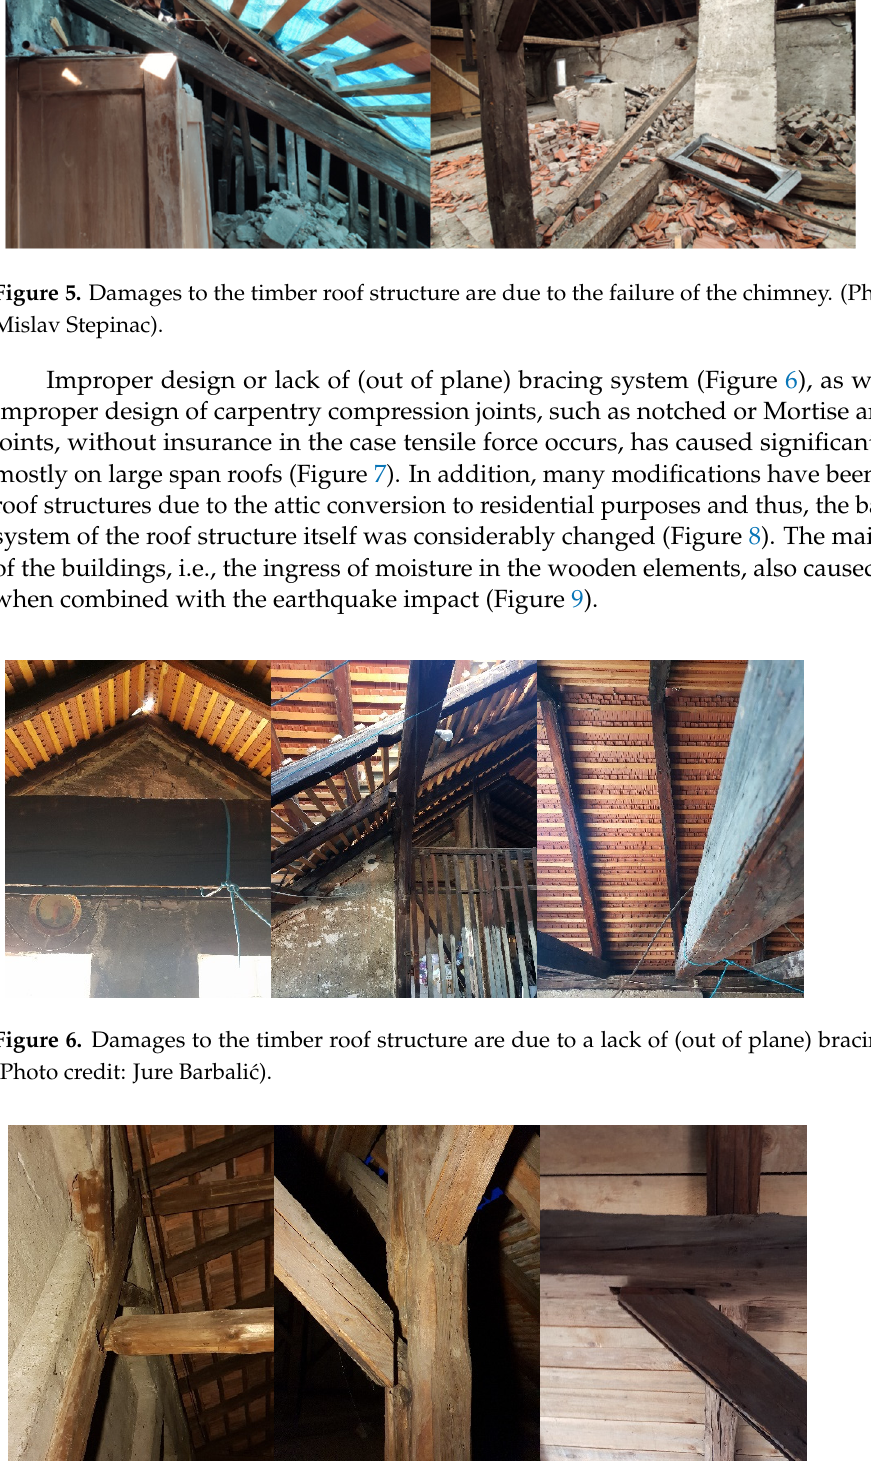
Figure 7. Damages to the timber roof structure are due to the improper design of carpentry com- pression joints. (Photo credit: Jure Barbali ć ).